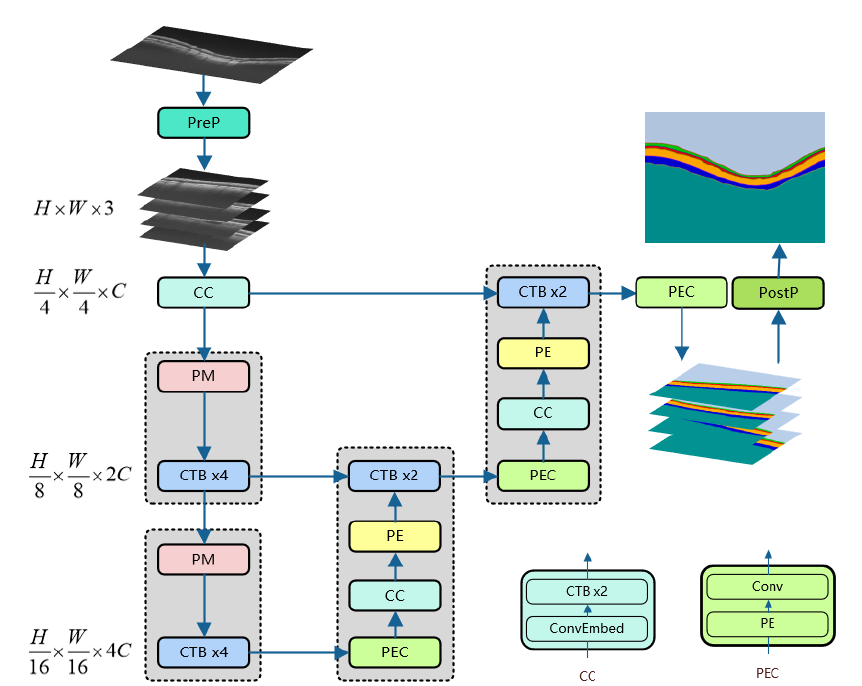
Figure 1. The architecture of CTS-Net. Among them, PE, CTB, PM, PreP, and PostP are the ab- breviations of Patch Expanding, CSWin Transformer Block, Patch Merging, Pre-processing, and Post-processing,